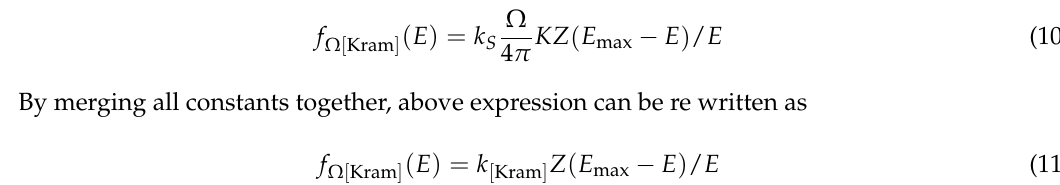
Intensity of photons confined to solid angle at the source